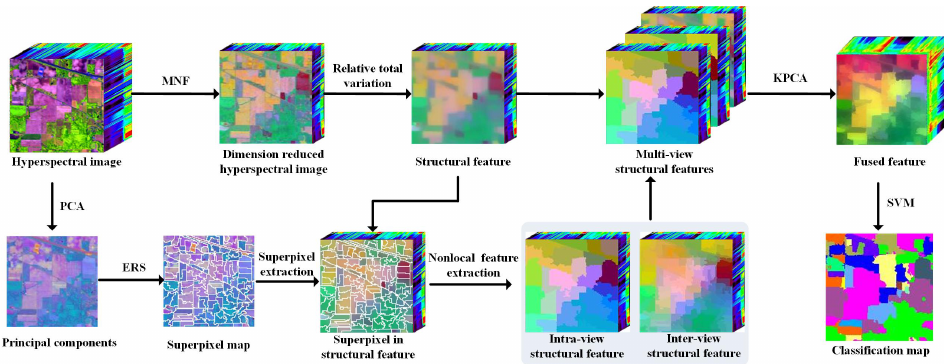
Figure 1. The flow chart of the proposed multi-view structural feature extraction